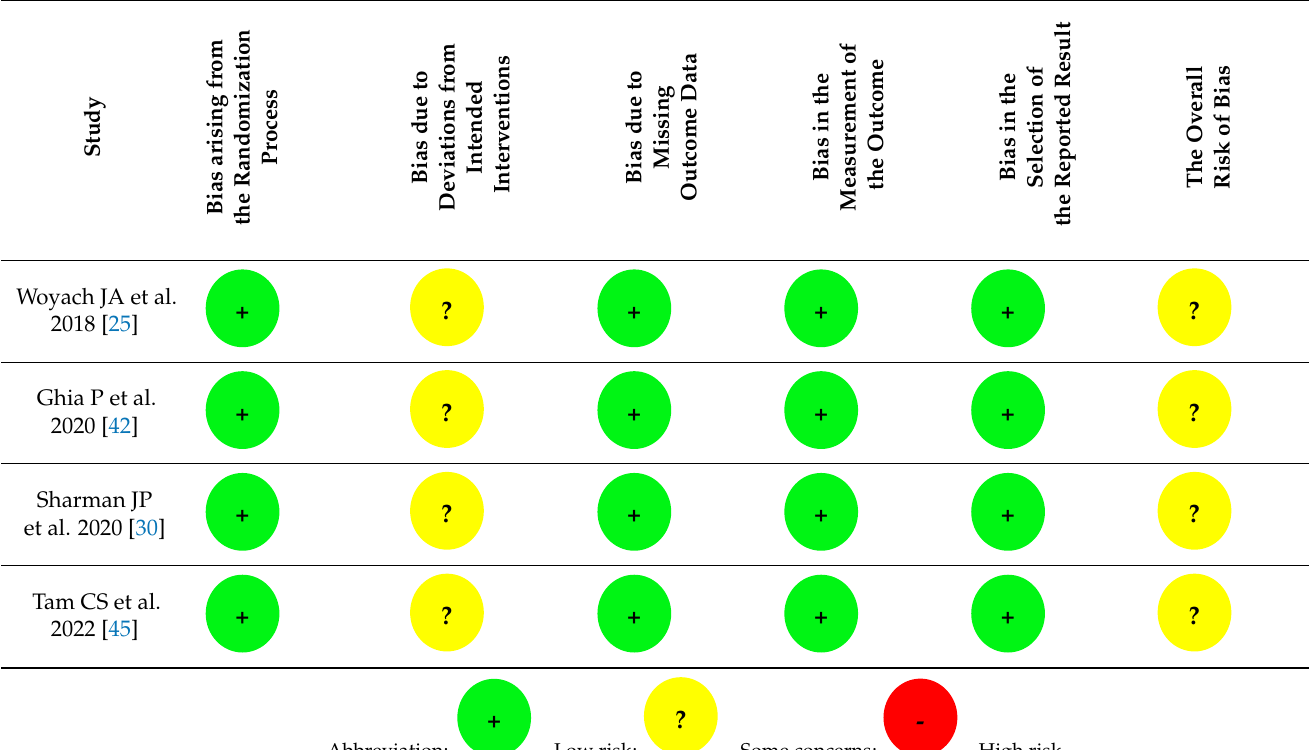
Table 3. Risk of bias evaluation of the included randomized trials using the ROB 2 tool.